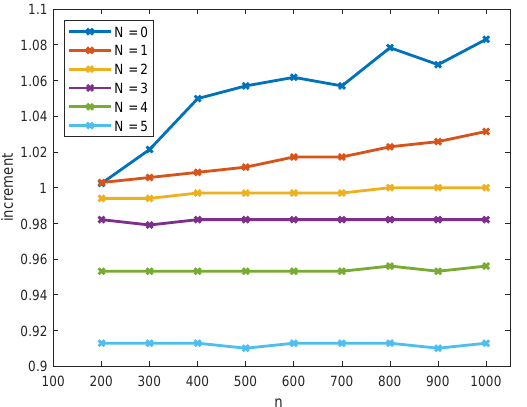
Figure 9. Increment factor of middle term of the analytical formula (29) as n x increases for different N and constant λ = 10 − 4 . For the data, see Table